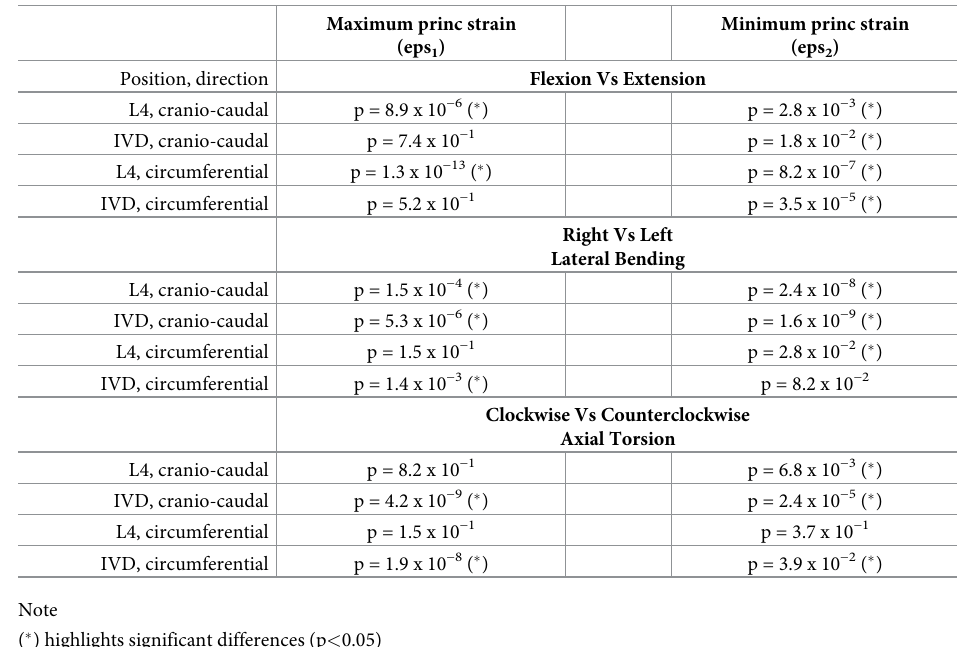
Table 3. The reported p-values show the statistical significance of the difference between the trends for opposite directions of loading (two-sample Kolmogorov-Smirnov). The distribution of strains (Figs 5, 6 and 7) in the cranio- caudal direction of the L4 vertebra and the L4-L5 intervertebral disc (computed as median strains over circumferential lines), and the distribution of strains in the circumferential direction of the L4 vertebra and the L4-L5 intervertebral disc (computed as median strains over cranio-caudal lines) were examined for the different loading